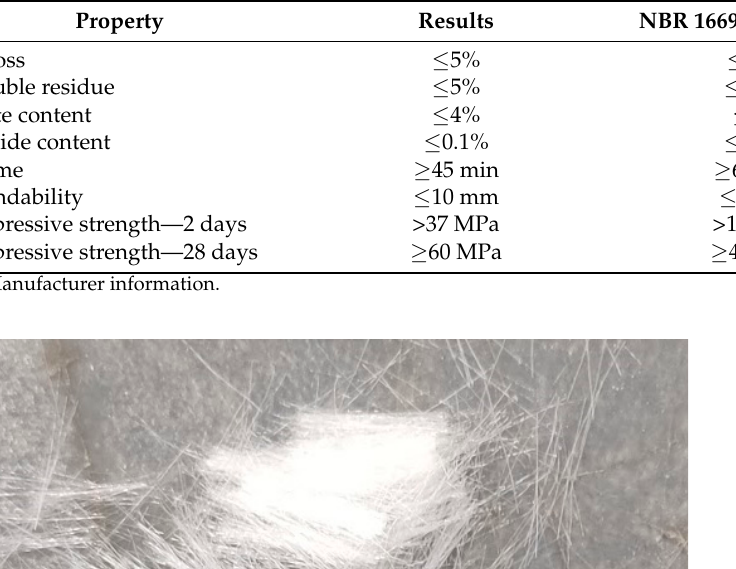
Table 1. Properties of the CPB-40 white Portland cement.